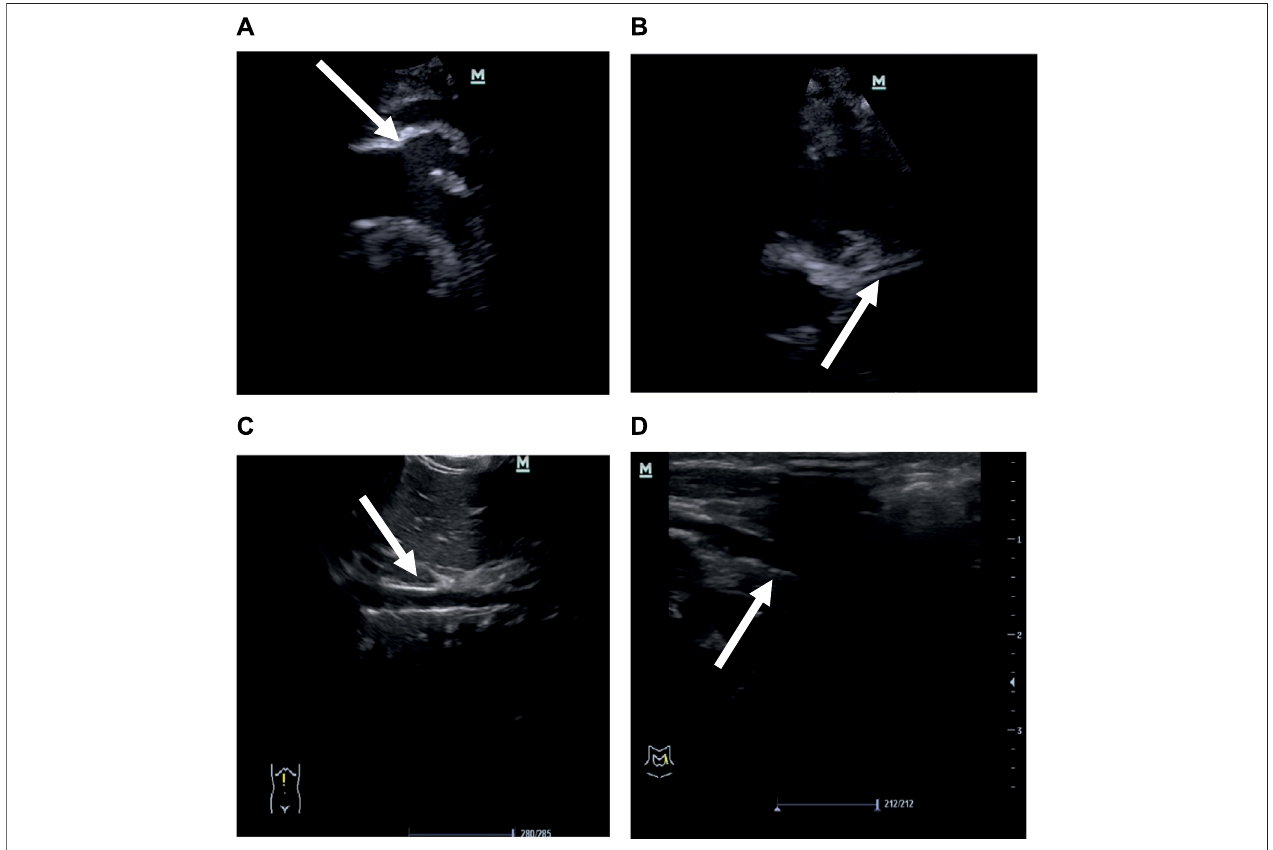
FIGURE 2 | Vascular ultrasound images. (A) Strong echo in the aortic arch and its branches is indicated by the arrows. (B) Strong echo in the left coronary artery wallisindicatedbythearrows. (C) Strongechointheabdominalaorticwallisindicatedbythearrows. (D) Strongechointhefemoralarterywallisindicatedbythearrows.